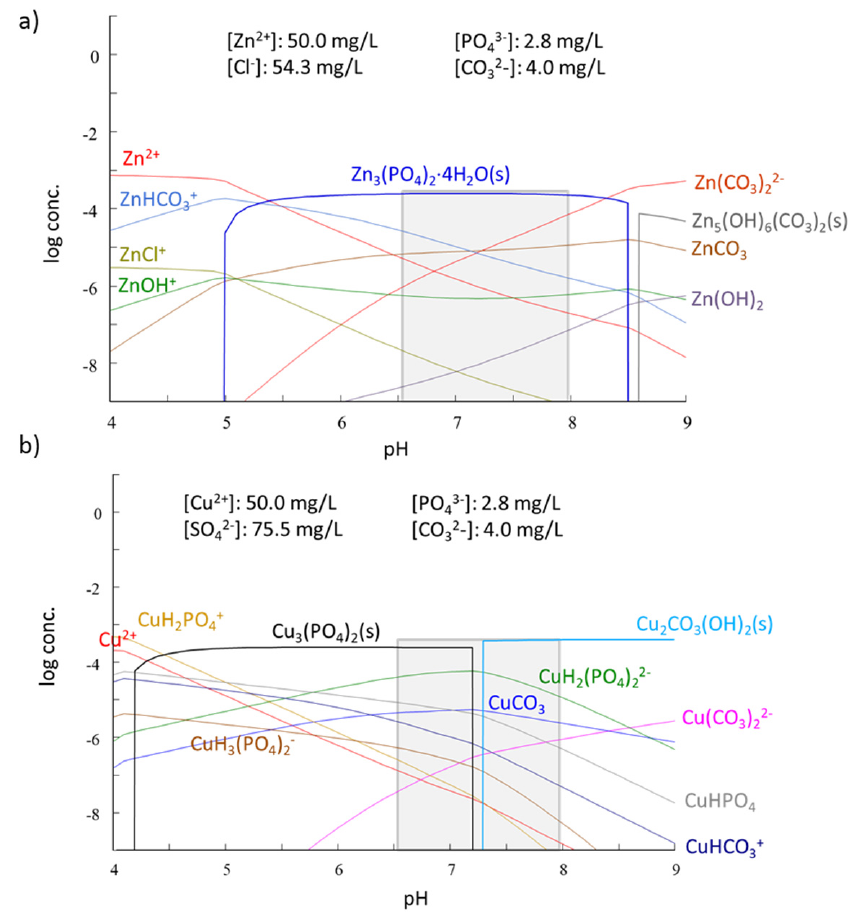
Figure 9. Species distribution diagram as a function of pH for ( a ) Zn and ( b ) Cu with a total metal concentration of 50 mg/L in a matrix representative of the supernatants containing the counter-ion in the metal salt (Cl − for Zn and SO 4 2 − for Cu), CO 3 2 − and PO 4 3 − . Minor species are not shown. The grey bars indicate the pH value of experiments. Distribution diagrams have been plotted using the software packages Hydra and Medusa [51].